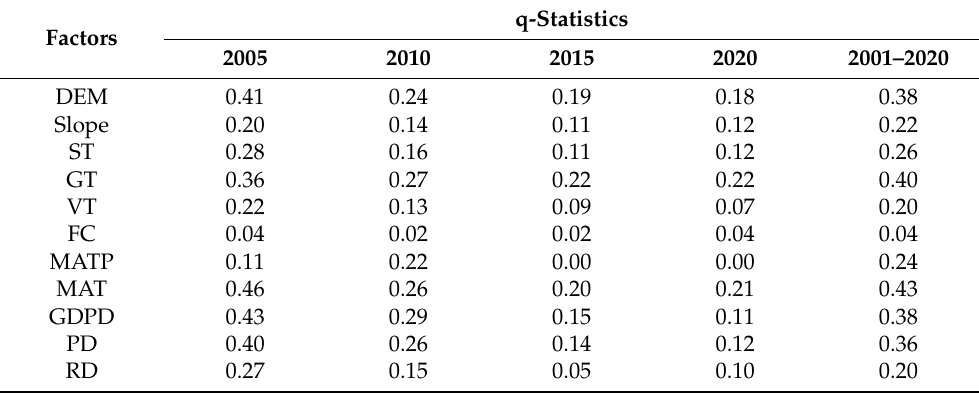
Table 3. Values for q-statistics for the different factors and